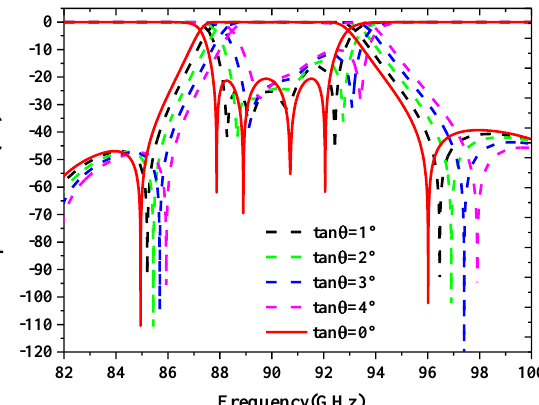
Figure 7. The sensitivity analysis of the steepness of the designed filter is based on simulations.